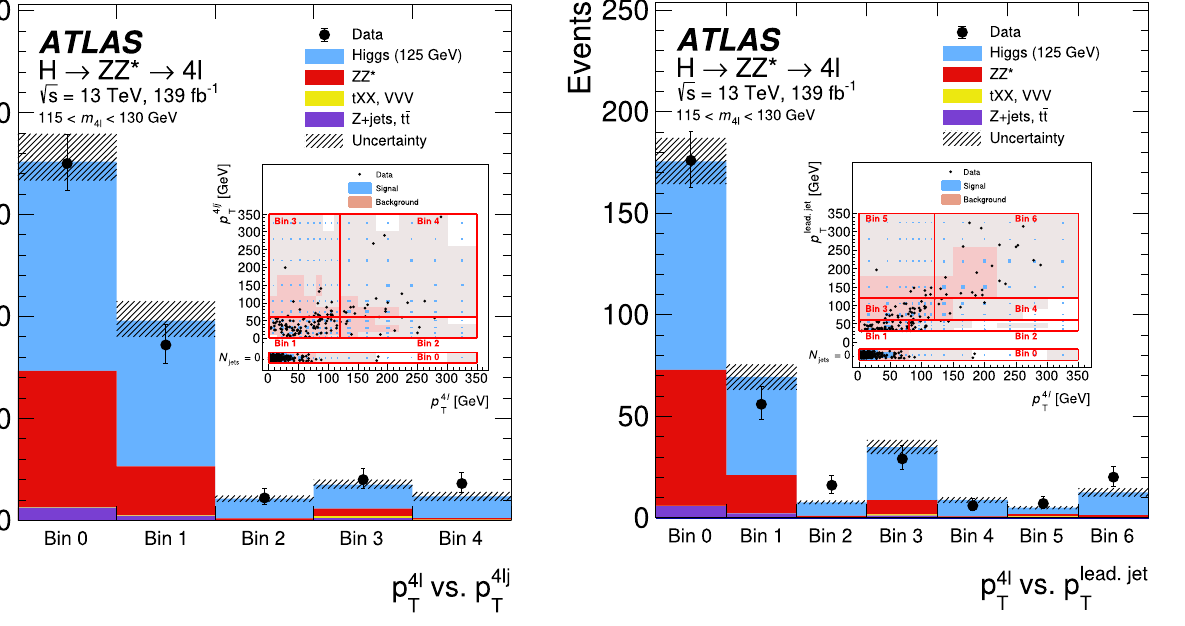
Fig. 15 The observed and expected (pre-fit) distribution in bins of Fig. 14 The observed and expected (pre-fit) distribution in bins of the transverse momentum of the four-lepton system vs. the transverse the transverse momentum of the four-lepton system vs. the transverse . jet (cid:3) j momentum of the leading jet, p 4 (cid:3) vs. p lead . The same distribution in momentum of the four-lepton plus leading-jet system, p 4 (cid:3) vs. p 4 . The T T T T the 2D plane is provided in the inset plot, where the black dots depict same distribution in the 2D plane is shown in the inset plot, where the data and the blue and pink shaded areas represent simulated signal black dots depict data and the blue and pink shaded areas represent and background, respectively. The red lines depict the bin boundaries, simulated signal and background, respectively. The red lines depict the chosen as described in Sect. 7. These distributions correspond to the bin boundaries, chosen as described in Sect. 7. These distributions cor- mass region 115 < m 4 (cid:3) < 130 GeV for an integrated luminosity of respond to the mass region 115 < m 4 (cid:3) < 130 GeV for an integrated √ √ 139 fb − 1 collected at s = 13 TeV. A SM Higgs boson signal with a luminosity of 139 fb − 1 collected at s = 13 TeV. A SM Higgs boson mass m H = 125 GeV is assumed. The uncertainty in the prediction is signal with a mass m H = 125 GeV is assumed. The uncertainty in the shown by the hatched band, which includes the theoretical uncertainties prediction is shown by the hatched band, which includes the theoret- of the SM cross section for the signal and the Z Z ∗ ical uncertainties of the SM cross section for the signal and the Z Z ∗ background